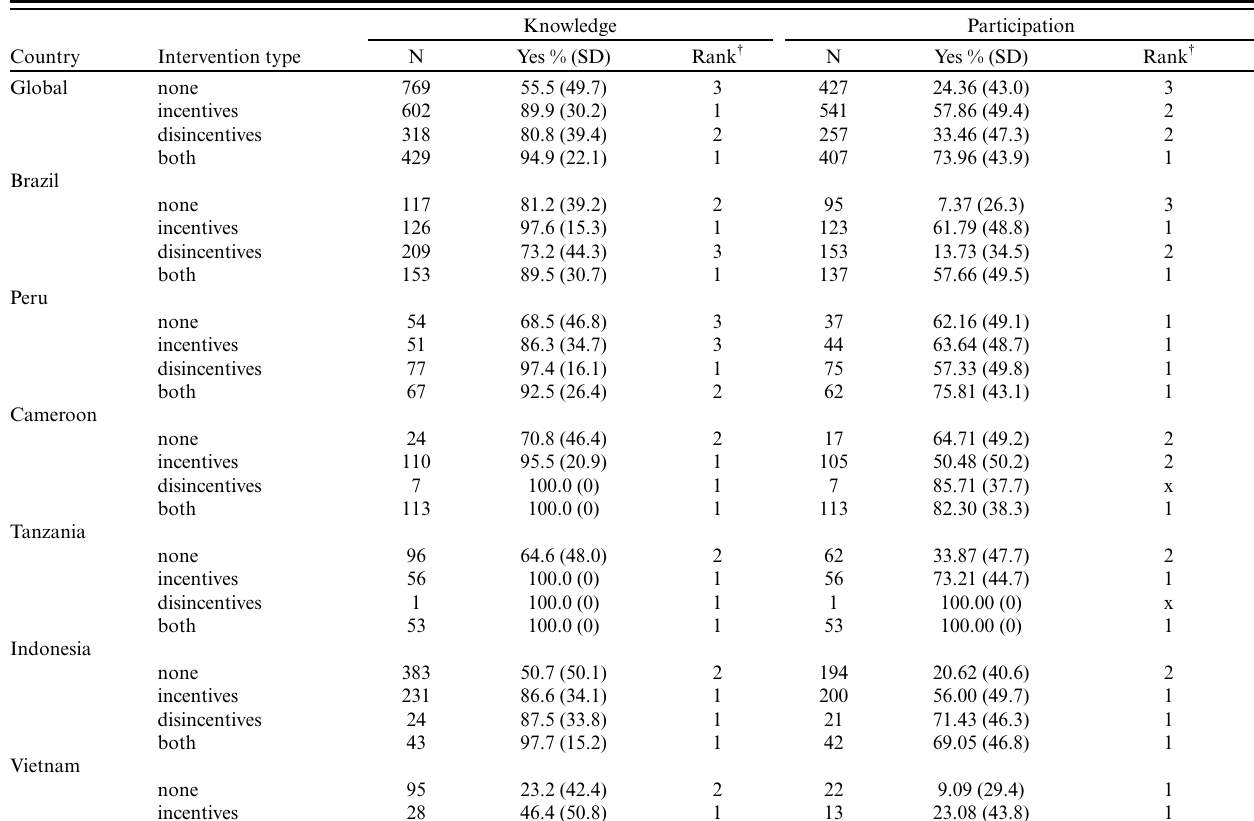
Table 4 . Percent of households at REDD+ sites in phase 2 reporting knowledge of and participation in local REDD+ initiatives, expressed as % of “yes” answers (standard deviation).